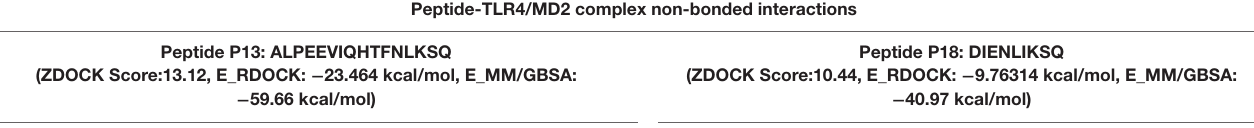
TABLE 3 | Details of non-bonded interactions between the peptides and TLR4/MD2 complex. Peptide-TLR4/MD2 complex non-bonded interactions